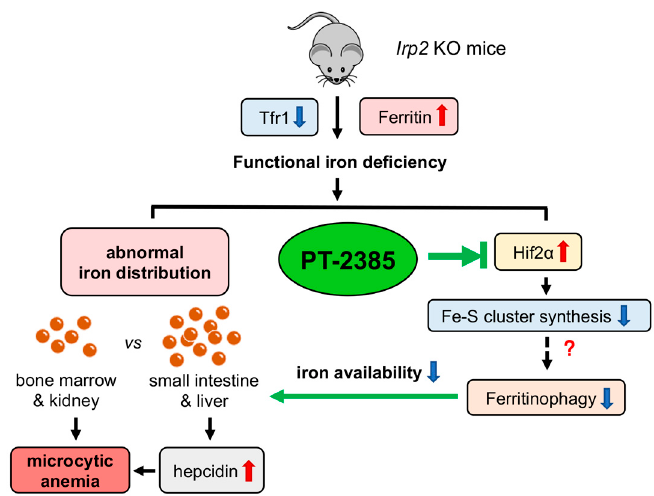
Figure 7. Working model of the role of Irp2 KO-induced upregulation of Hif2 in microcytic anemia. Irp2 deficiency causes functional iron deprivation by reducing cellular iron uptake (downregulated transferrin receptor 1, Tfr1) and increasing cellular iron storage capacity (upregulated ferritin), eventually leading to the development of microcytic anemia symptoms in Irp2 KO mice. Iron accumulation was observed in the intestine and liver, but iron deficiency was seen in erythropoiesis- related organs such as bone marrow and kidney. At the molecular level, Irp2 deficiency increases Hif2 α expression, interferes with Fe-S cluster synthesis, and may affect ferritinophagy, resulting in decreased iron availability. Furthermore, elevated levels of hepcidin secreted by the liver aggravate the abnormal iron distribution. Hif2 α inhibition by PT − 2385 alleviated symptoms of anemia in Irp2 KO mice by increasing ferritinophagy levels.